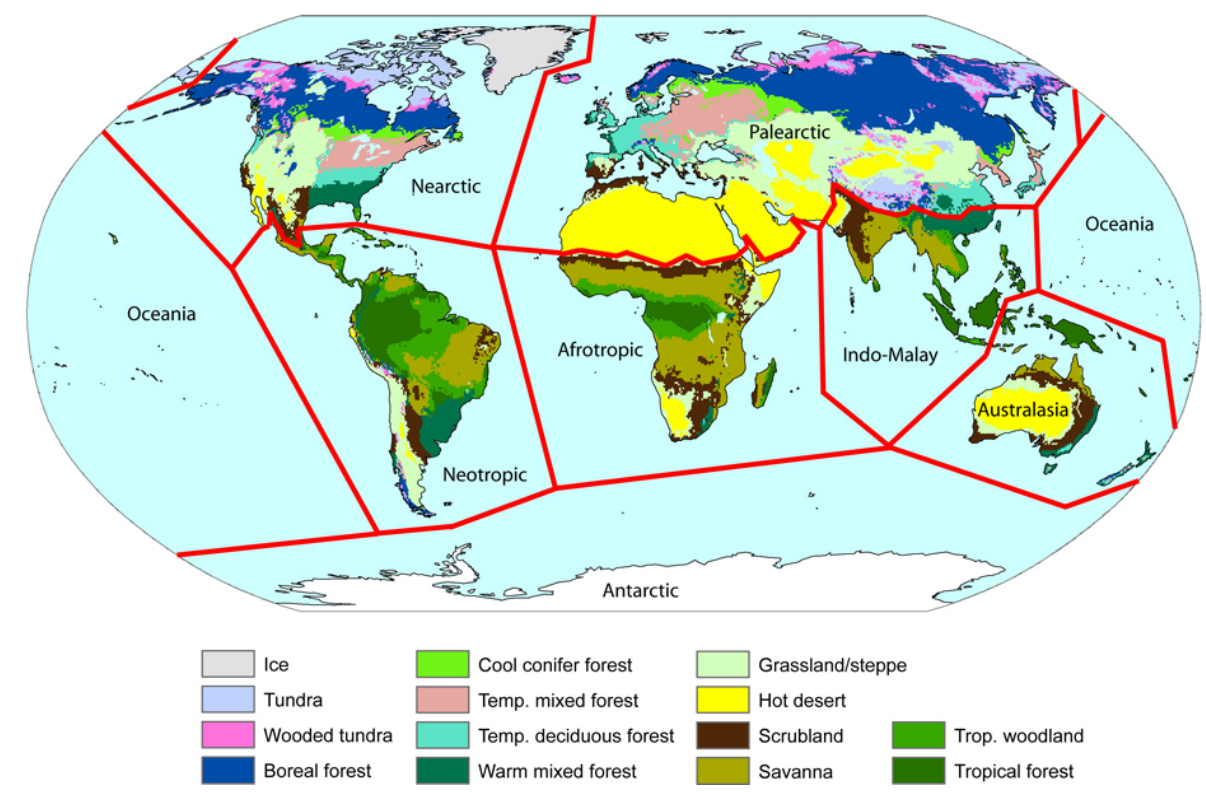
Fig. 1. The biogeographical units used as basis for the species-area relationships. Each unique combination of one of the 14 natural biome types of the IMAGE model and the biogeographic realms of Olson et al. (2001) is defined as an unit, e.g., all boreal forest in the Paleartic realm. The realms "Oceania" and "Antartic" have not been considered separately in the analysis, leaving a total of six